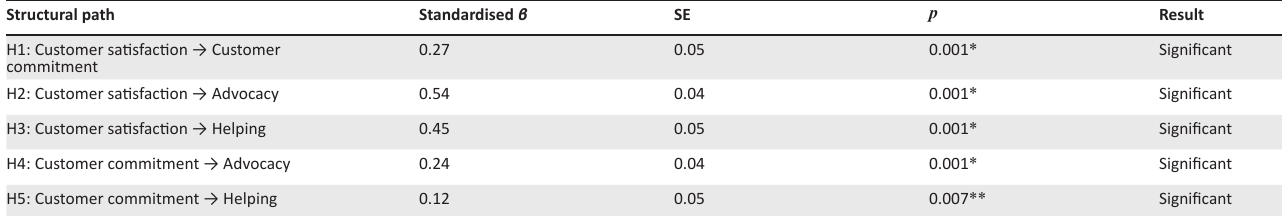
TABLE 3: Regression results for the structural model. Structural path